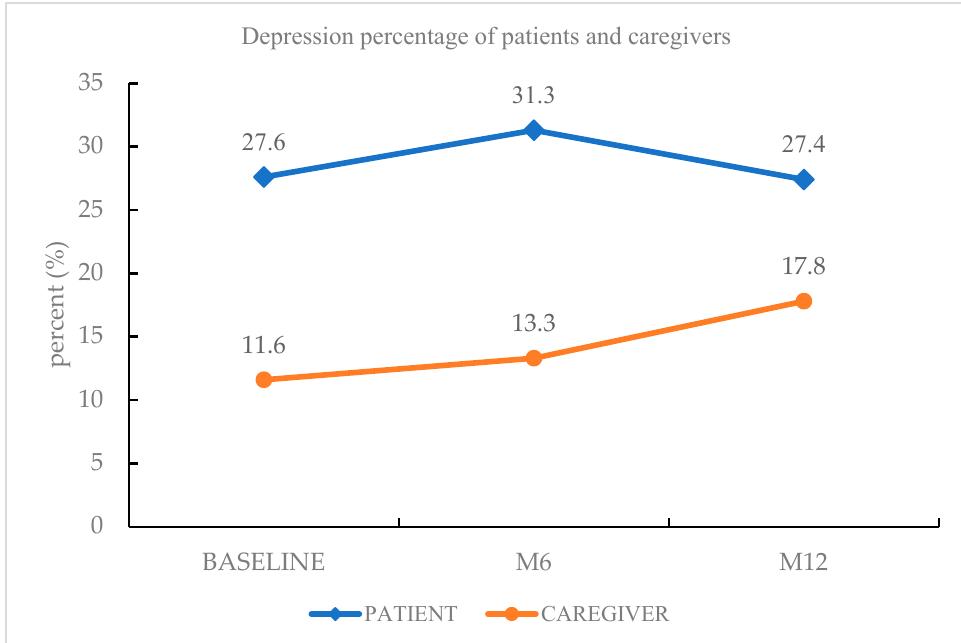
Figure 1. Depression morbidity of PD patients and caregivers.